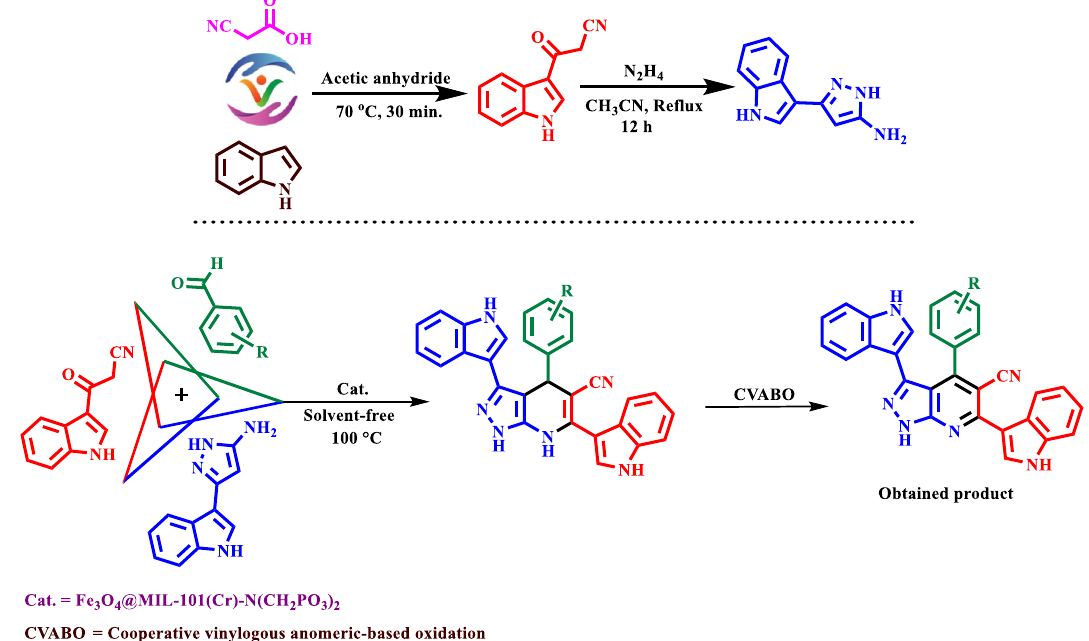
Figure 2. Preparation of novel mono and bis and tris pyrazolo[3,4- b ] pyridine using Fe 3 O 4 @MIL-101(Cr)- N(CH 2 PO 3 ) 2 as